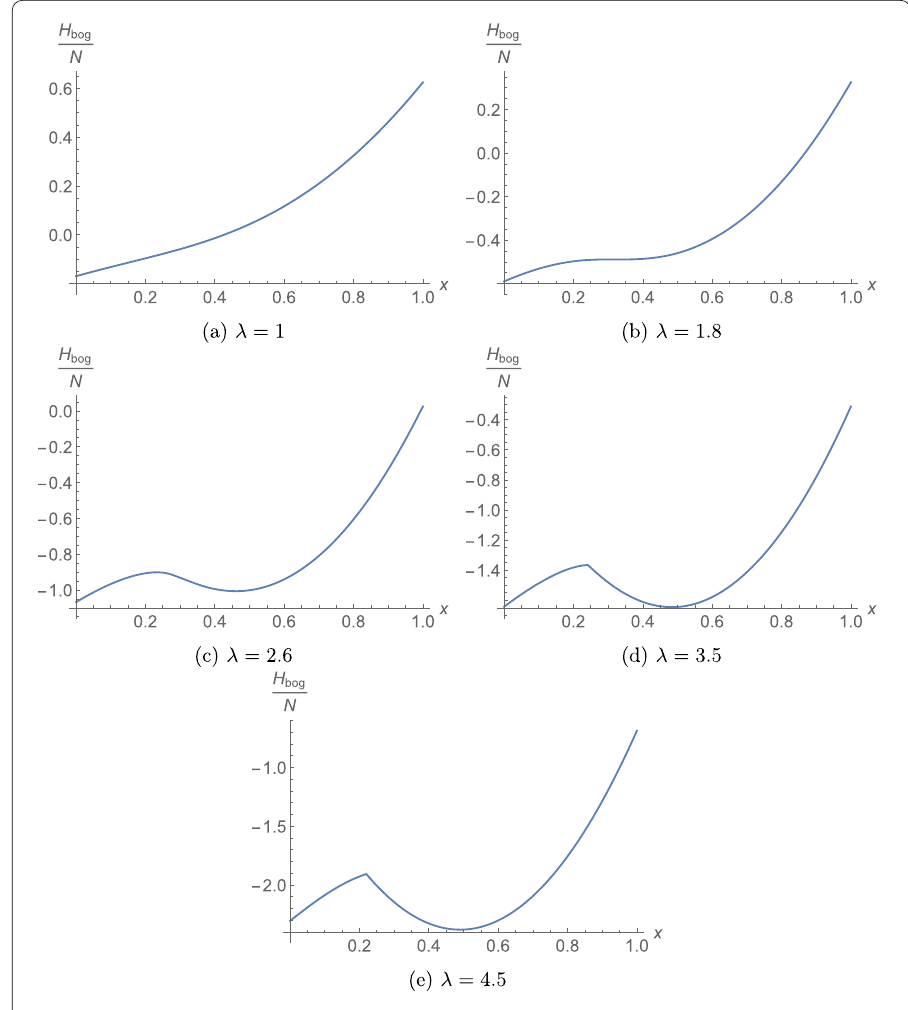
Figure 4 Minimal value of the Bogoliubov Hamiltonian (rescaled by the inverse particle number) subject to the constraint that the relative occupation of the 2-mode is x . At λ lm ≈ 1.8, a stationary inflection point signals the appearance of a second minimum and at λ gs ≈ 3.5, this second minimum becomes energetically